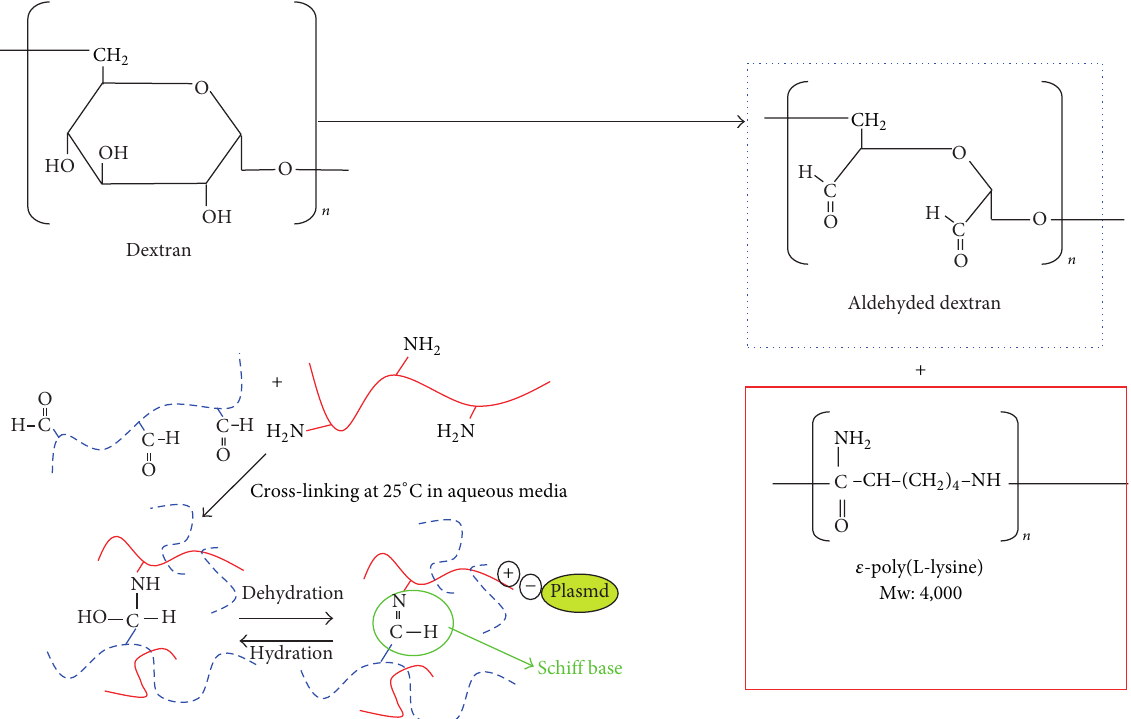
Figure 1: The chemical structure and cross-linking of the new biodegradable hydrogel composed of aldehyded dextran/PLL and plasmid DNA. After the mixture of the solution, gel formation proceeds on the basis of Schiff base formation. Plasmid DNA interacts with PLL by electrostatic interactions between positively charged amine of the PLL and negatively charged phosphate groups of the plasmid